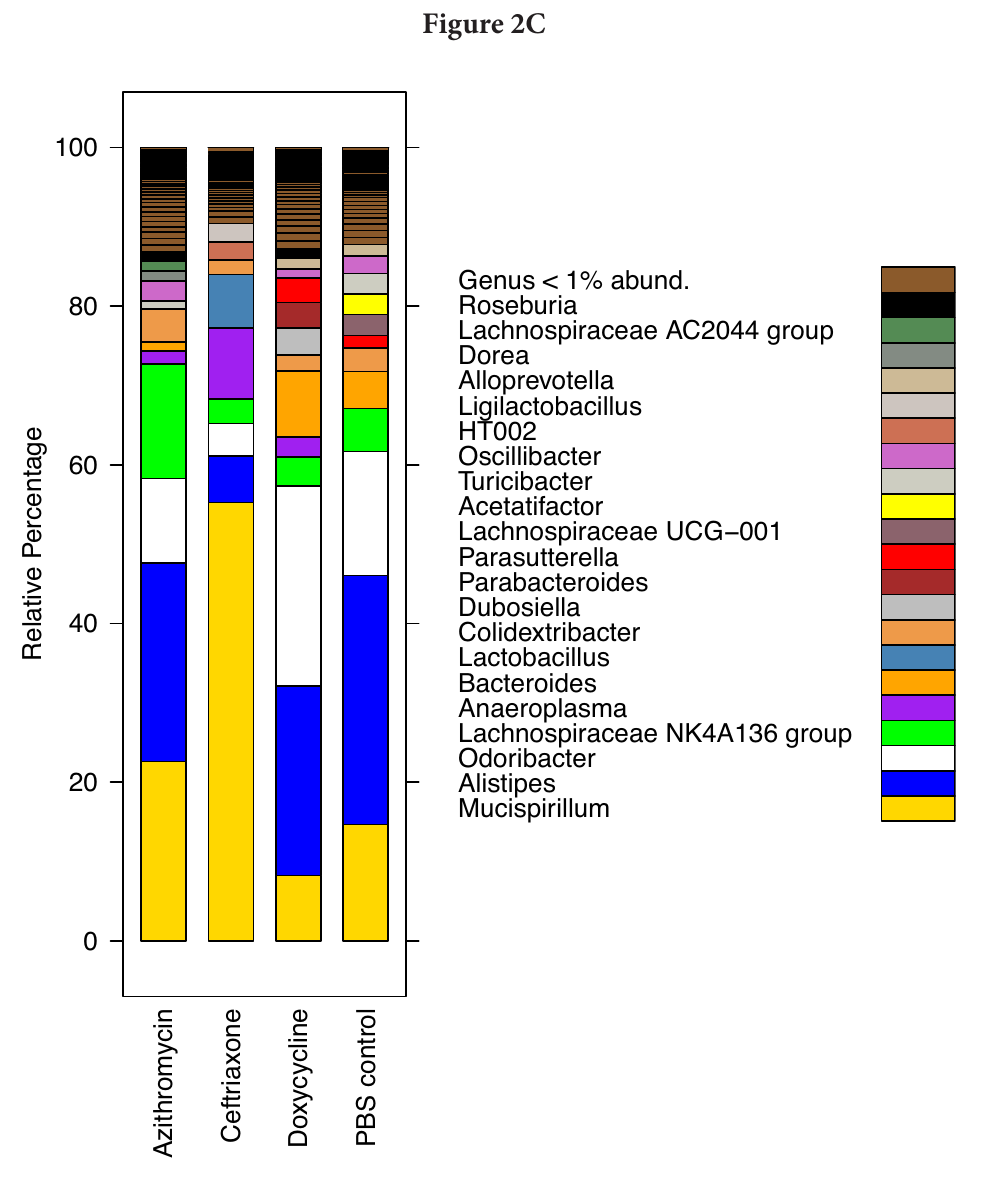
Figure 2 . Impact of treatment with phosphate-buffered saline (PBS), doxycycline, azithromycin, or ceftriaxone on the total bacterial diversity in the stool of mice. A) Alpha Simpson diversity index; B) Beta diversity canonical correspondence analysis (CCA); C) Relative percentage abundance of different bacterial taxa. Black horizontal lines associated with the box plots represent median